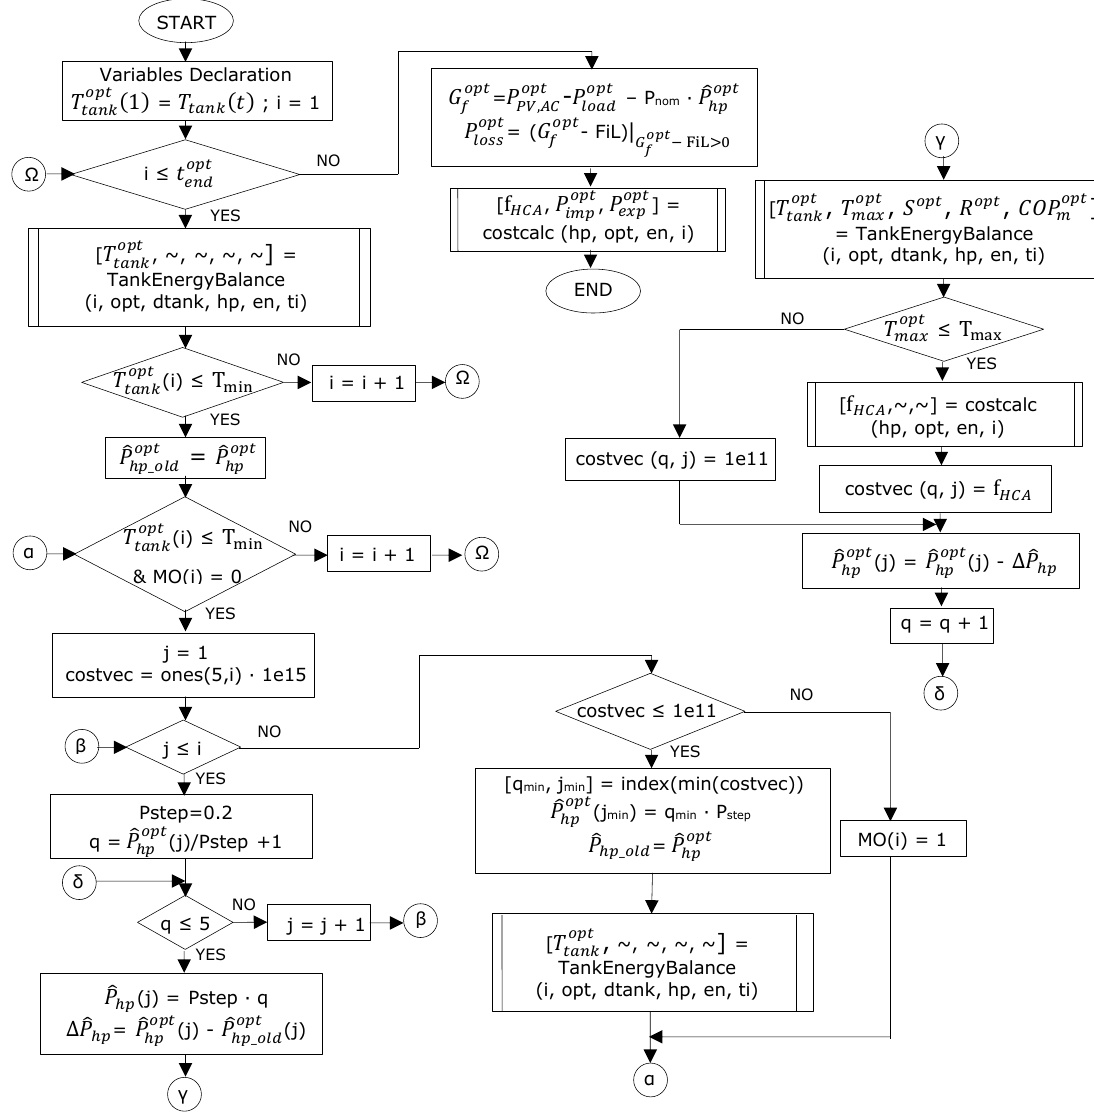
Figure 3. Flowchart of the heuristic control algorithm